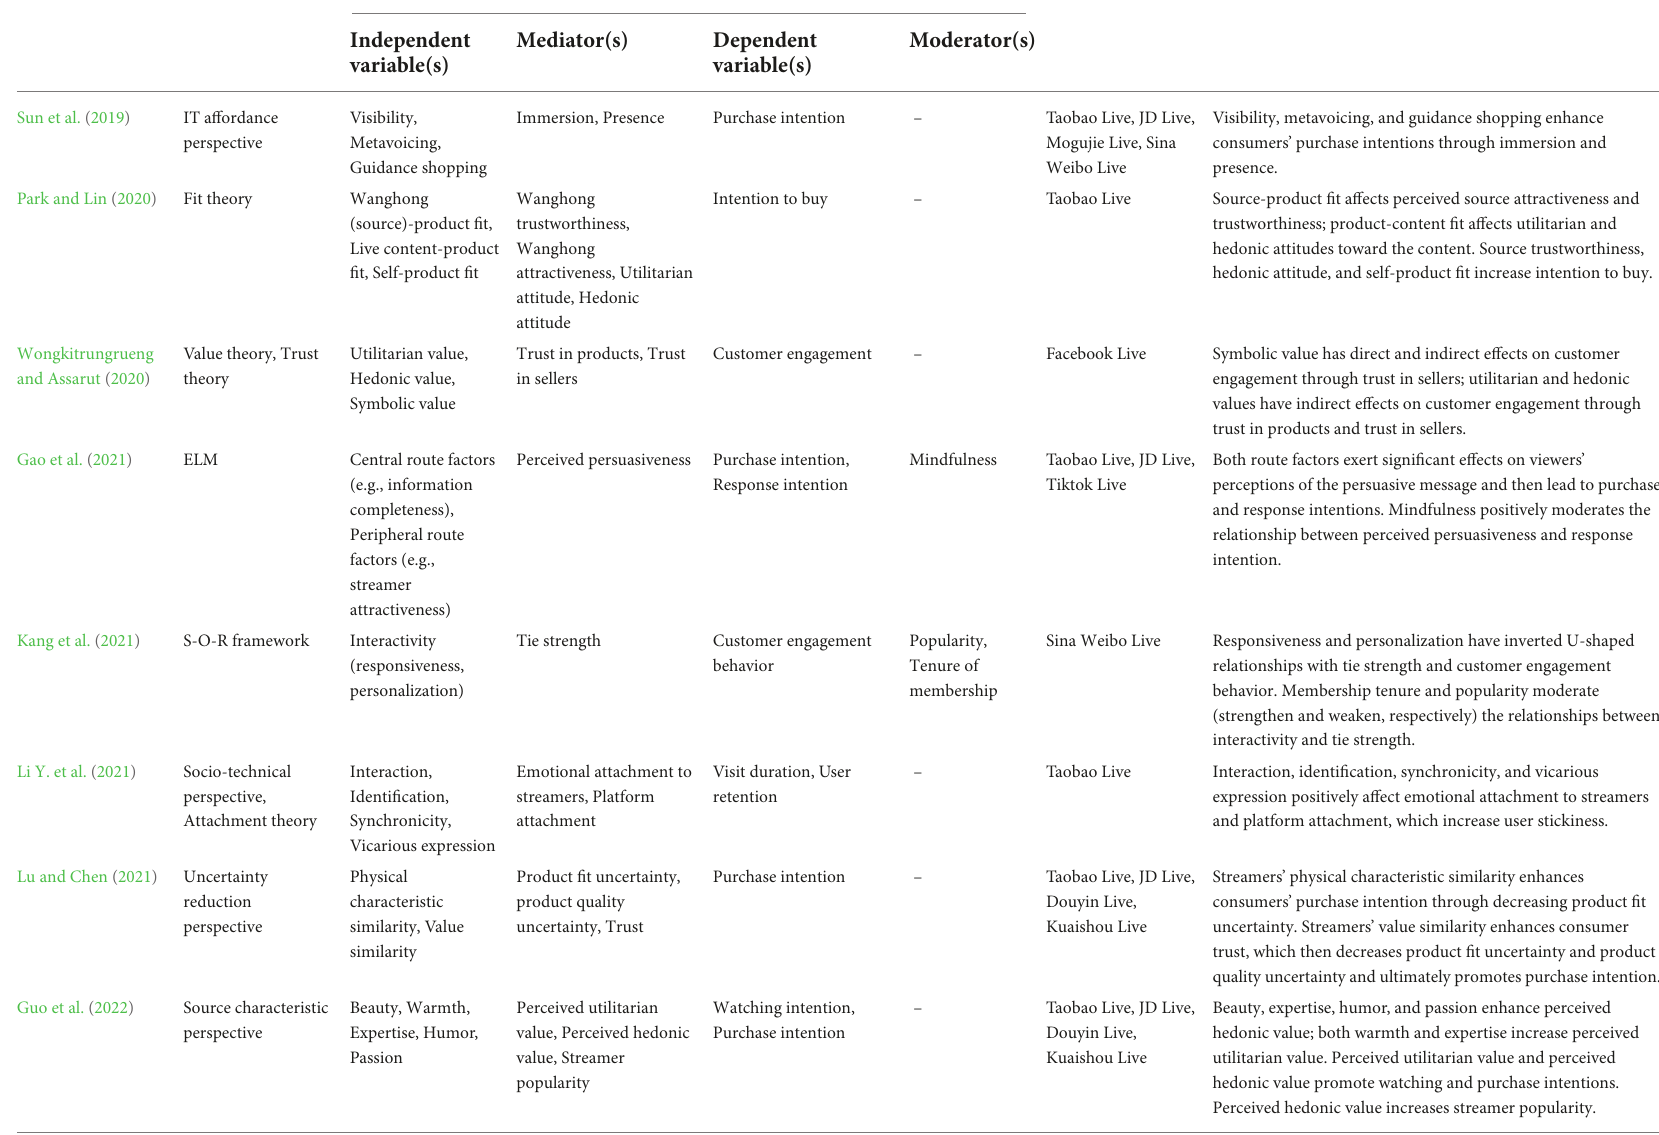
TABLE 1 Summary of related research in live streaming